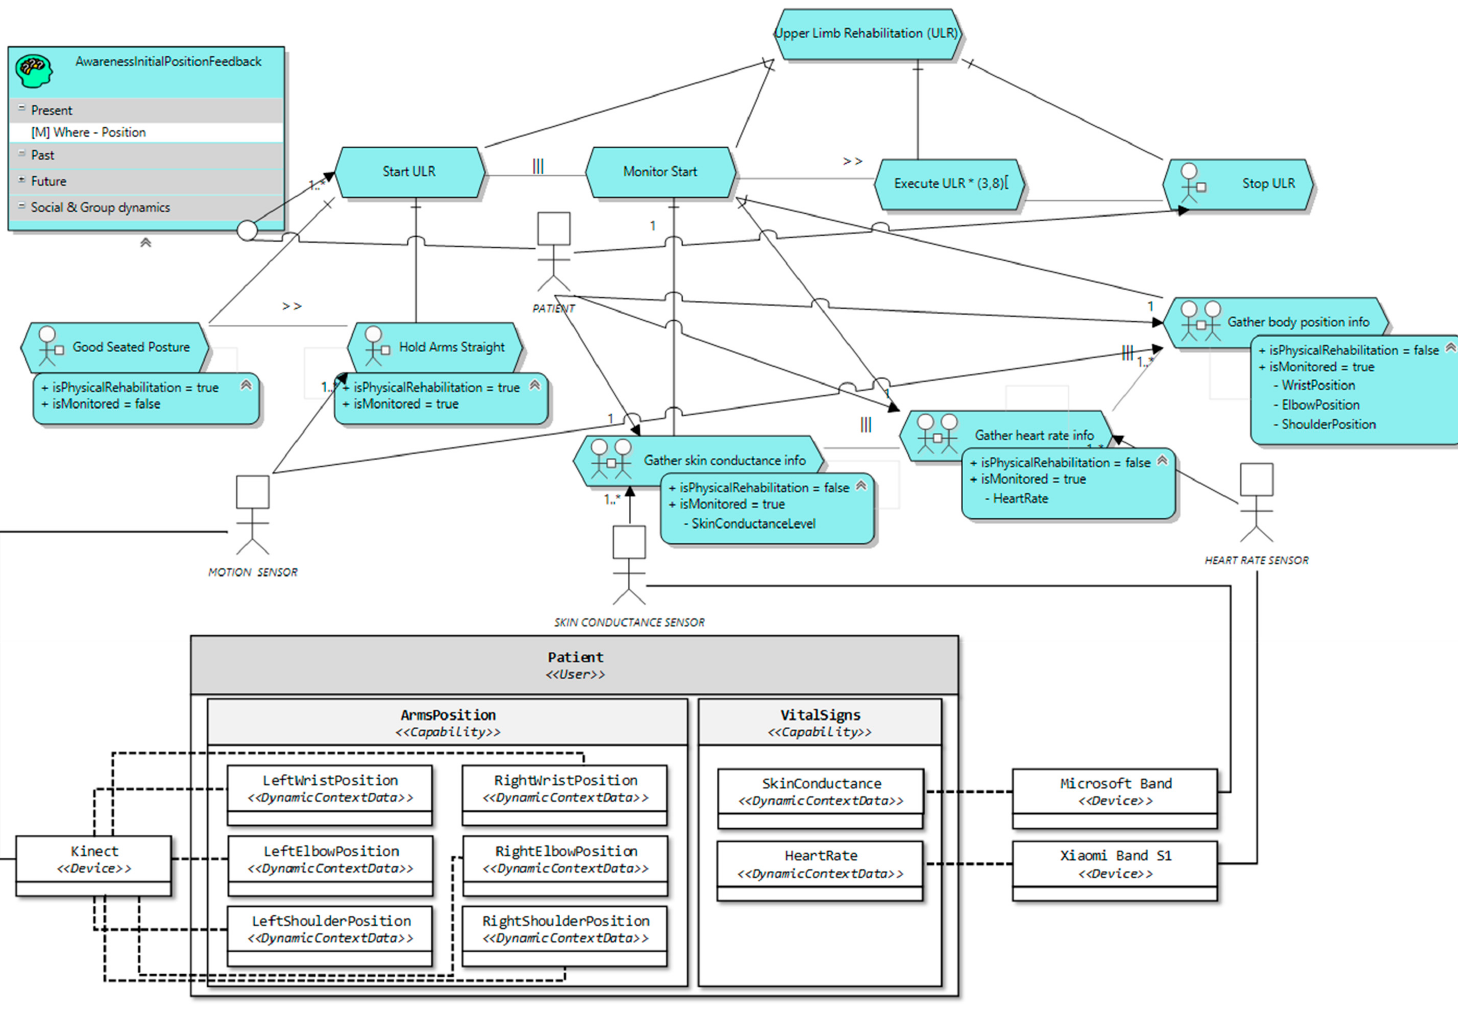
Figure 8. The upper limb rehabilitation task model with context